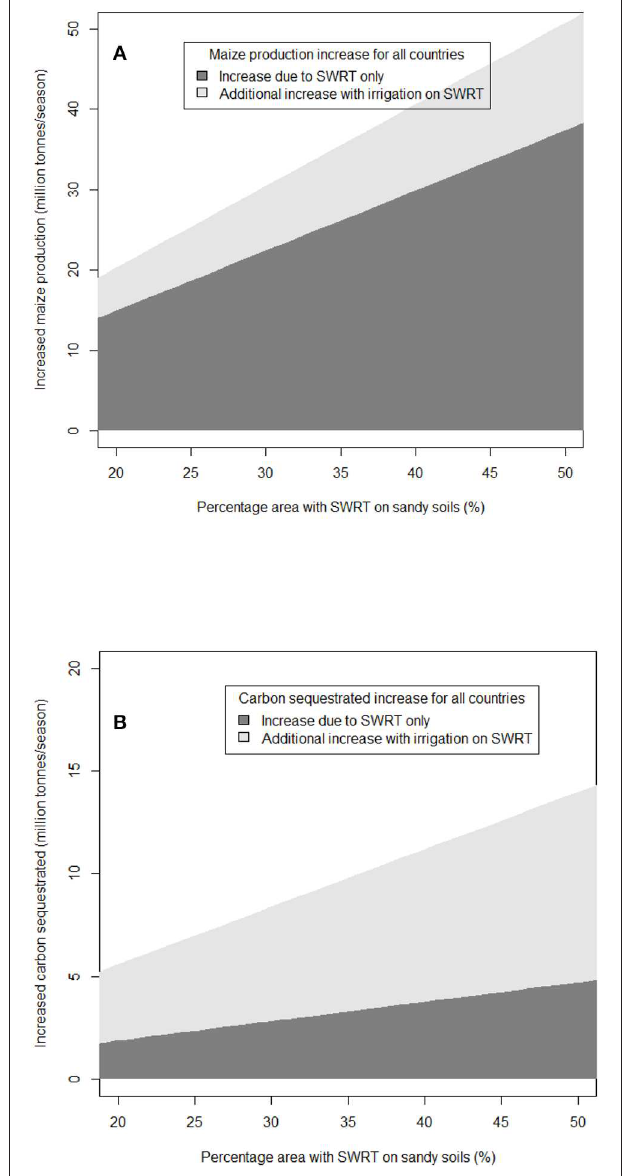
FIGURE 5 | Estimates of maize production increases (A) and carbon sequestration (B) for 20 to 50% of new land under the adoption of SWRT for all the eight countries. The dark gray area represents the added value of SWRT without irrigation while the light gray area is the added value brought about by irrigation after SWRT adoption. Increases of grain yield were based on experimental results, local maize production yields levels for 2012, 2013, and 2014 (Food and Agriculture Organization, 2018) with the existing coarse-textured soils in the